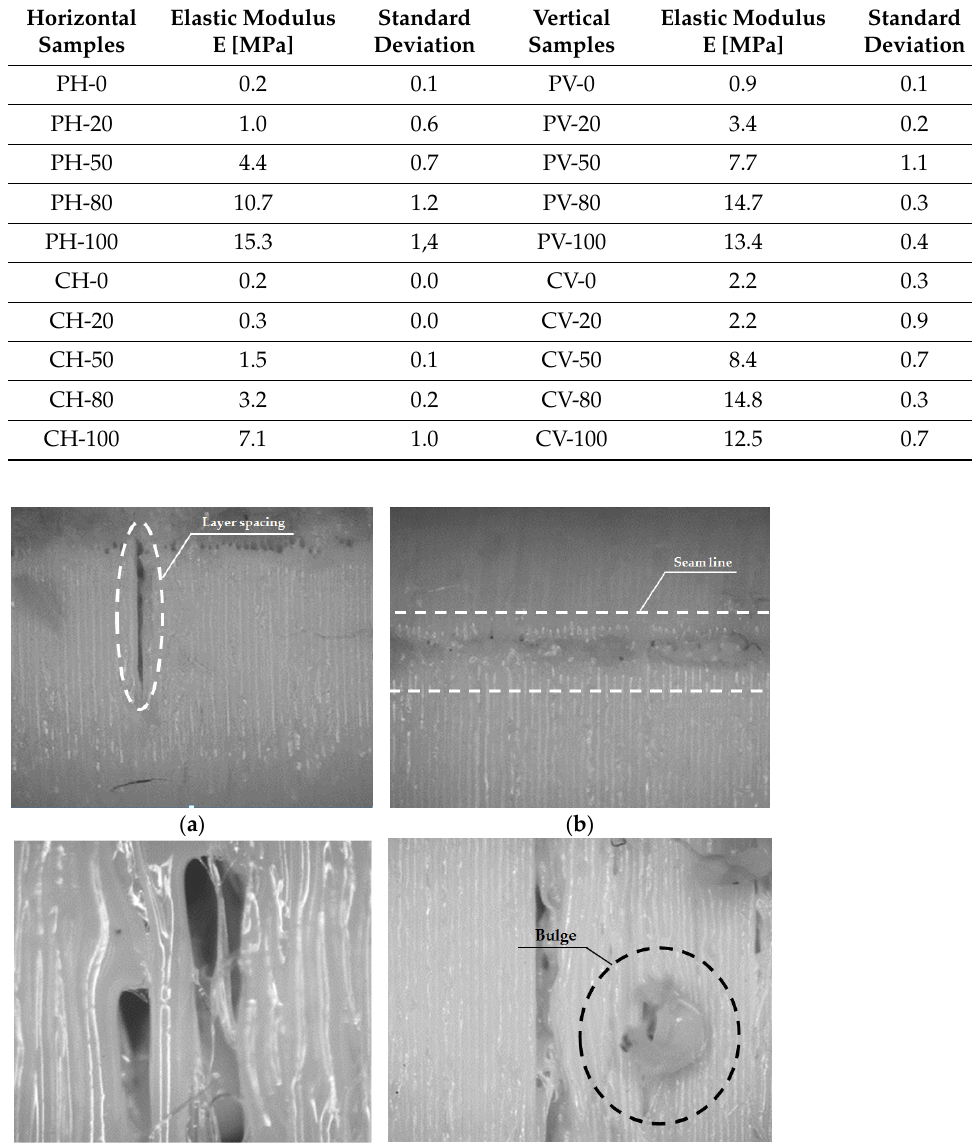
Table 4. Optimal manufacturing process parameters defined for Filaflex ® 82A TPU filament. P